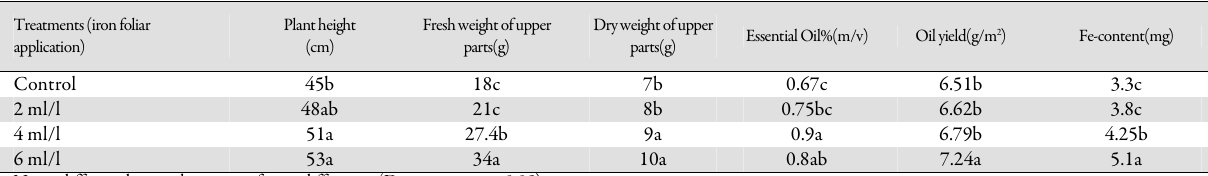
Tab. 1. Effect of foliar application of Fe on several characters of Dracocephalum moldavica L.